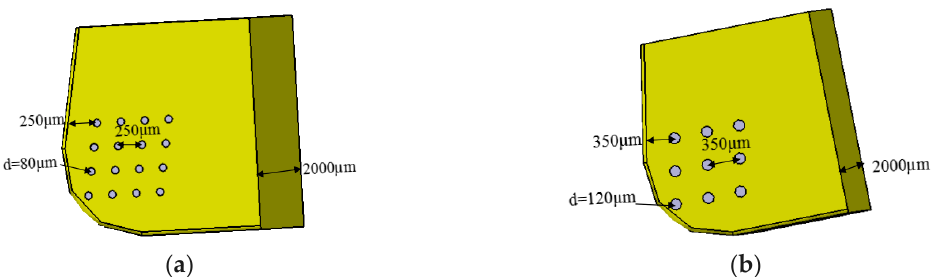
Figure 2. 3D model of micro-hole tools: ( a ) d = 80 µm micro-hole tool; ( b ) d = 120 µm micro-hole tool.